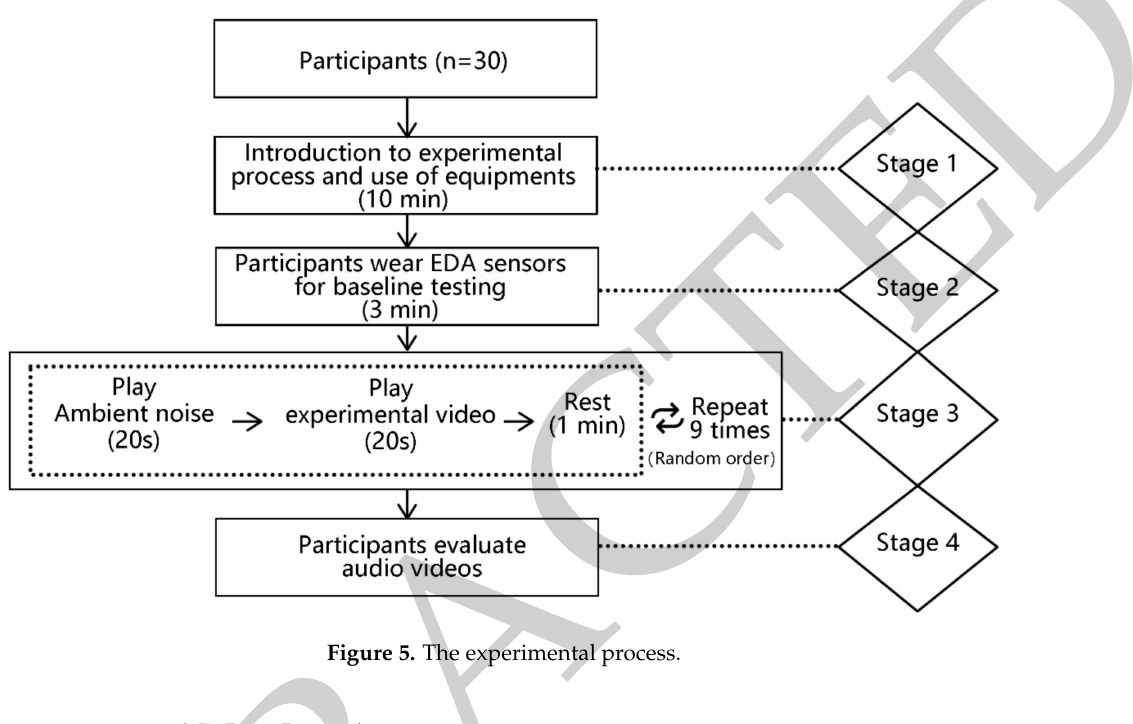
Figure 5. The experimental